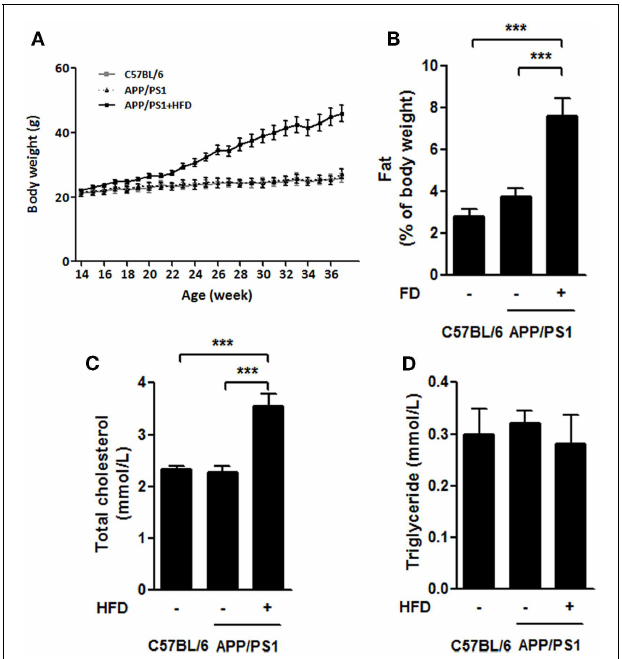
FIGURE 1 | High-fat-diet-induced weight gain inAPP/PS1 mice . Throughout the experiment, the body weights of C57BL/6 and APP/PS1 mice had no difference, and significant body weight gain was induced after HFD feeding for 8weeks (at 22 weeks) and sustained growing from then on (A) .The ratio of parametric fat pad weight to body weight (B) of APP/ PS1 + HFD mice was significantly higher than that of the C57BL/6 and APP/PS1 mice.The serum level of total cholesterol in APP/PS1 + HFD mice was higher than those in the other two mice groups (C) . No difference in serum triglycerides was found among the three groups (D) . Data were means ± SEM. n = 10 for C57BL/6 mice, n = 12 for APP/PS1 mice, and n = 11 for APP/PS1 + HFD mice for body weight. n = 7 for C57BL/6 mice, n = 9 for APP/PS1 mice, and n = 8 for APP/PS1 + HFD mice for other measurements. All results were analyzed by one-way ANOVA, followed by Newman–Keuls post hoc test, except that the body weight result